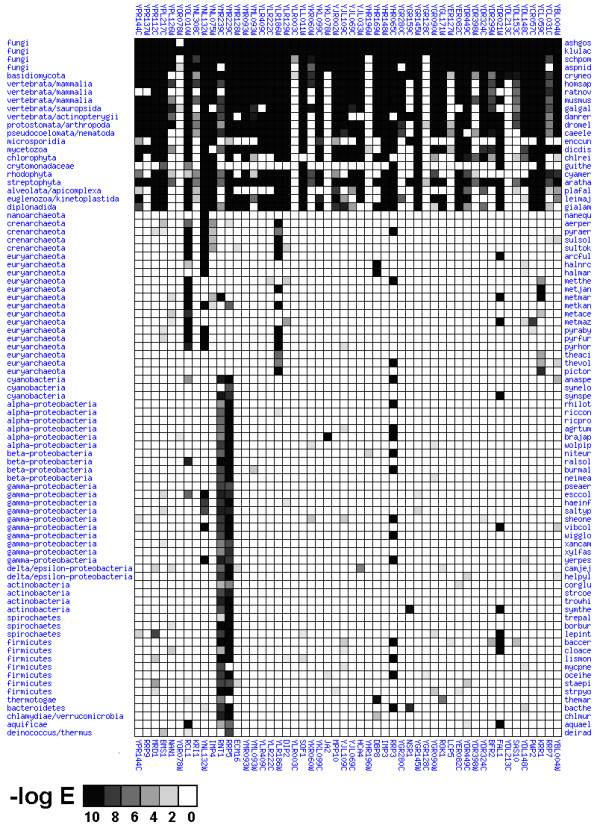
Phylogenetic profiling of the 90S processosome. Phylogenetic profiles of known yeast 90S processosome proteins across 84 organisms. Abbreviations given on the top of the plot represent organism names (first three letters for genus and first three letters of species names; see Materials and methods for a translation of abbreviations into organism names). Further taxonomic annotation is given on the bottom of the plot. Yeast open reading frame identifiers are given on the left side, and gene names and descriptions are given on the right side of the plot. The significance of sequence similarity is visualized by different shades of gray that reflect the logarithmic expectation (E) value from reciprocal BLAST searches (shown at the bottom of the figure). Here, the E values of BLAST searches using target proteome sequences as queries versus the yeast proteome reference database are shown. The genes are ordered according to hierarchical clustering (see Materials and methods). Note that there are only a few proteins with many prokaryotic orthologs when compared to Figure 3.